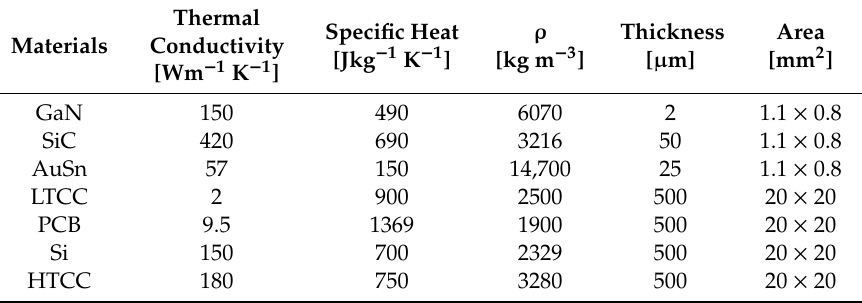
Figure 4. Maximum temperature of GaN chips (mounted on PCB) as a function of input power density obtained based on IR measurements and 3D FEM (finite element models) simulation results. Table 2. Characteristics of materials in thermal simulation.